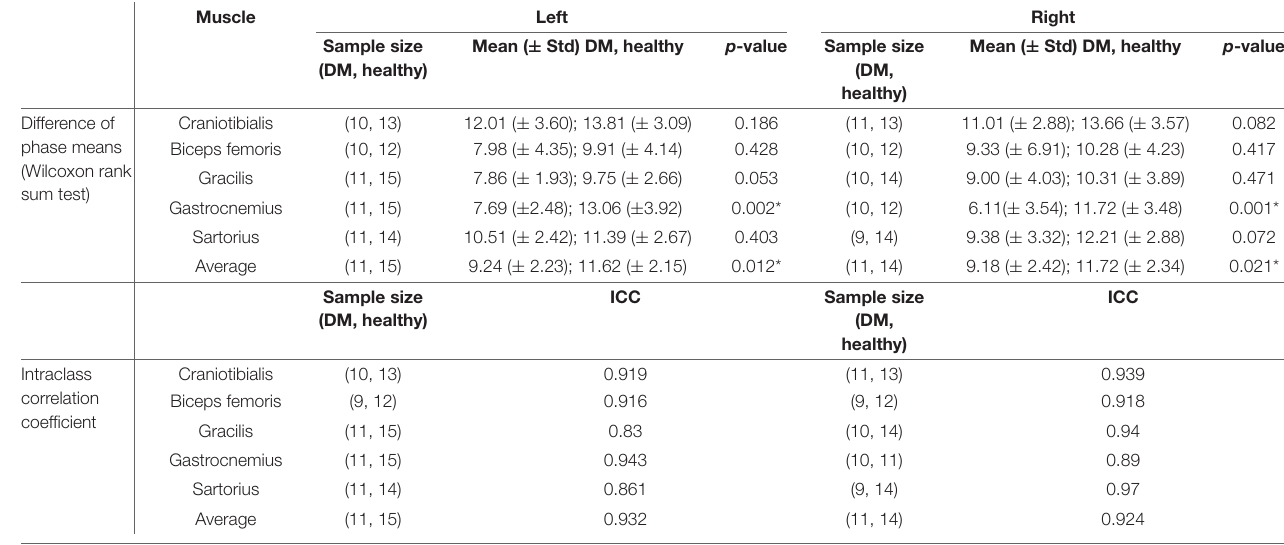
TABLE 1 | Phase values in DM-affected vs. control dogs and intraclass correlation coefficient of repeated phase measurements. Muscle Left